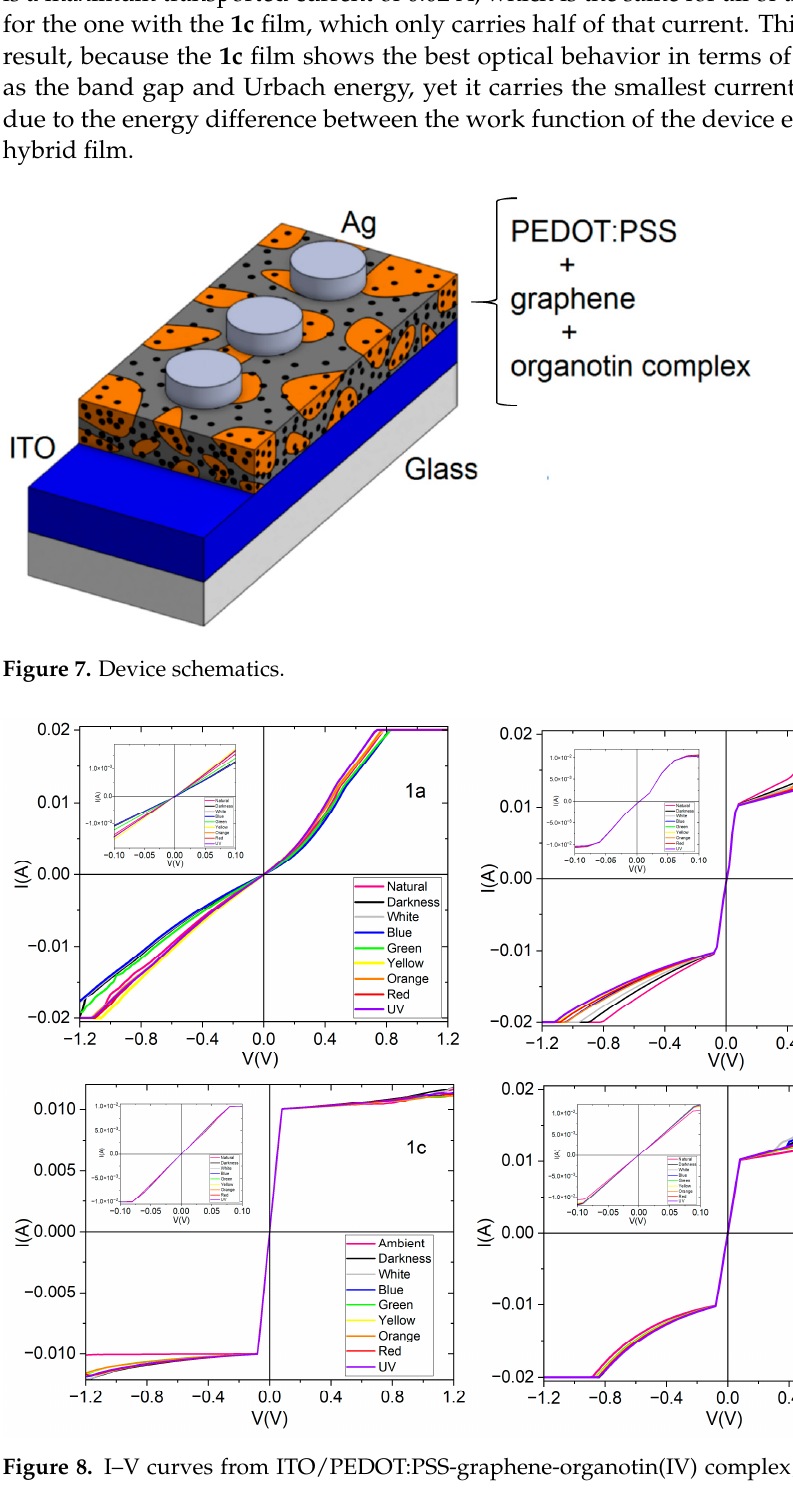
Figure 8. I–V curves from ITO/PEDOT:PSS-graphene-organotin(IV) complex/Ag devices under dif- ferent lighting conditions. As mentioned earlier, at low voltages, different lighting conditions do not signifi- cantly influence the ohmic behavior of the devices. This ohmic behavior can be described by the following equation [67]: